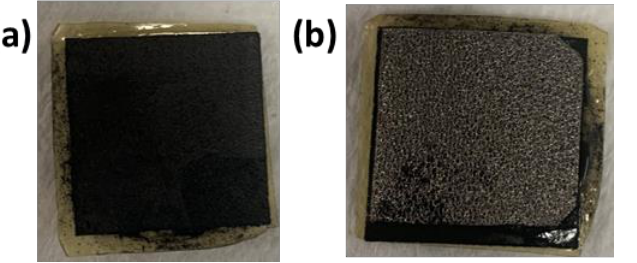
Figure 2. MEA after the electrolysis operation ( a ) MEA with cathode side (carbon paper) on top and ( b ) MEA with anode side (nickel foam) on top. The dimensions of the electrodes were 1.8 cm × 1.8 cm. Commercial Pt/C (40 wt%, HISPEC 4000, Johnson Matthey, London, UK) catalyst